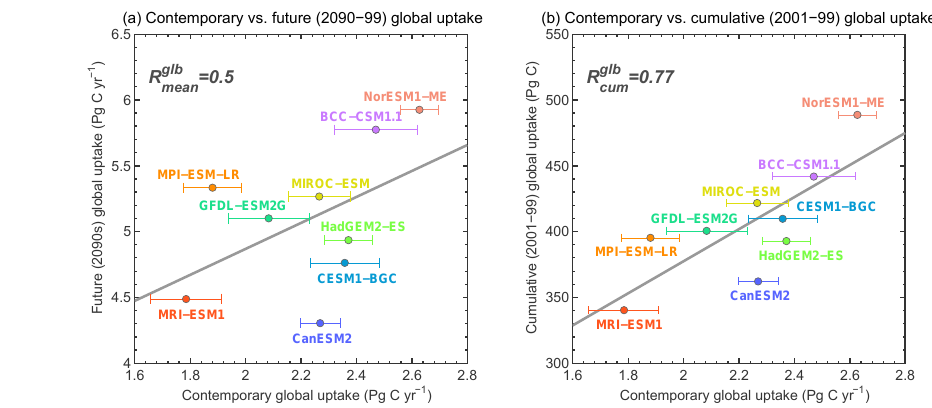
Figure 2. Global annual contemporary carbon uptake rate vs. (a) global future (2090–2099) carbon uptake and (b) cumulative global carbon uptake over 2001–2099. The straight gray lines show the best-fit linear regression across all models.